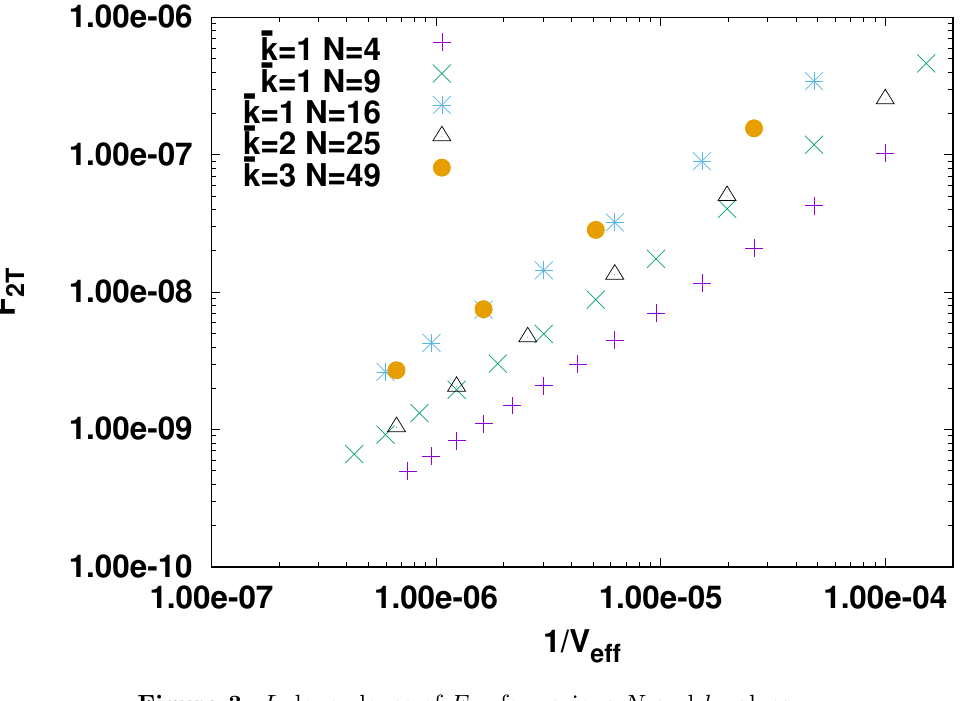
Figure 3. L -dependence of F 2 T for various N and k values.